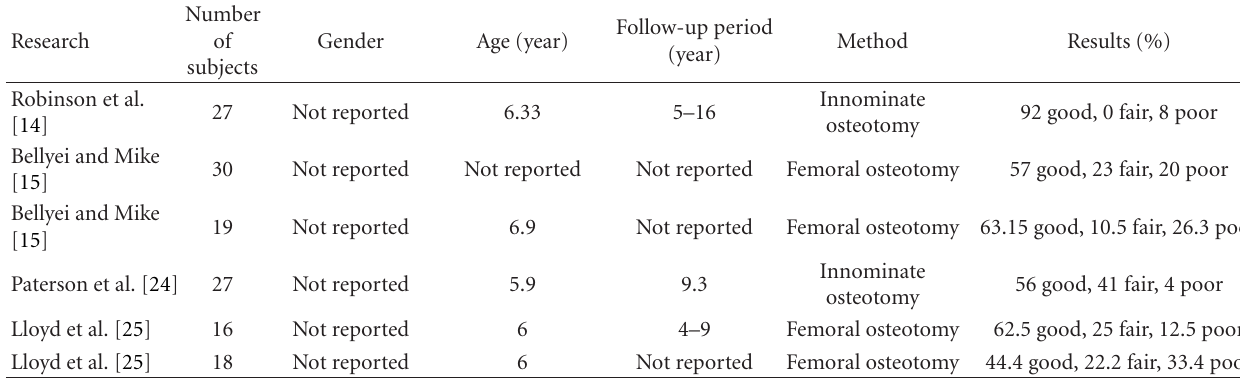
Table 6: The results of various research studies based on surgical operations.